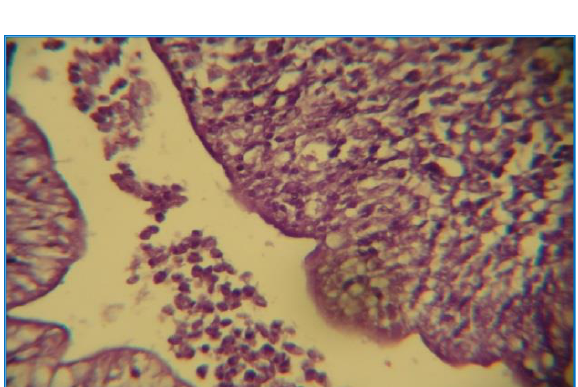
Figure, 6: Intestine of 2nd group after 240hrs. heat exposure no clear lesion seen. (H and E stain 400X).